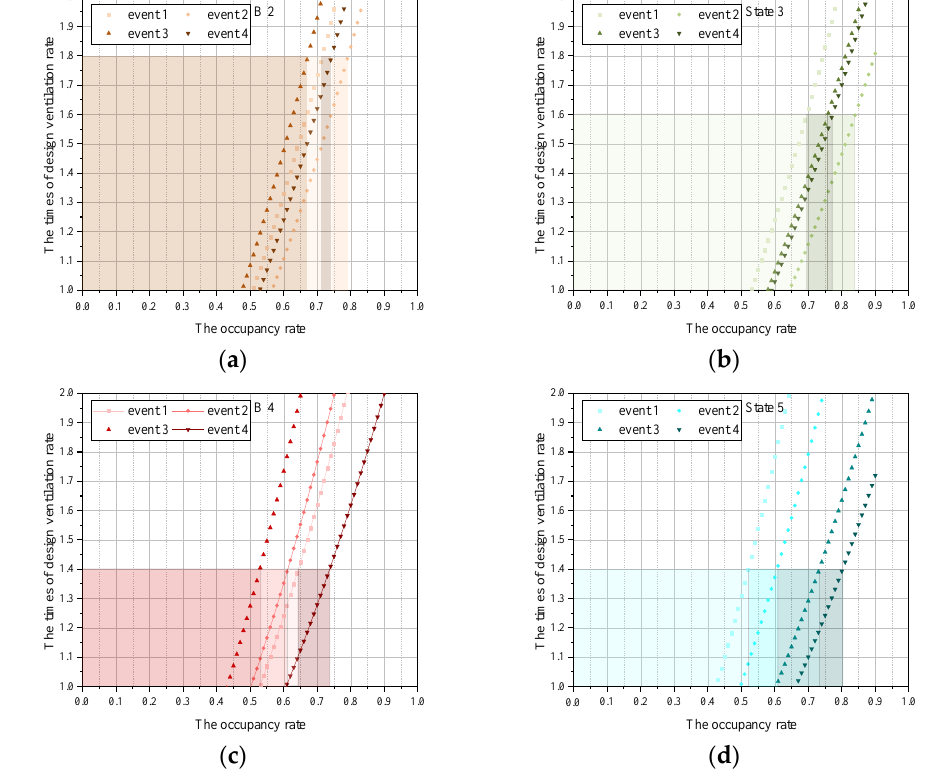
Figure 9. Upper limit of occupancy rate during the typical event under the minimum ventilation demand of B 2 – B 5. ( a ) Lecture building, ( b ) Office building, ( c ) Canteen building, ( d ) Library